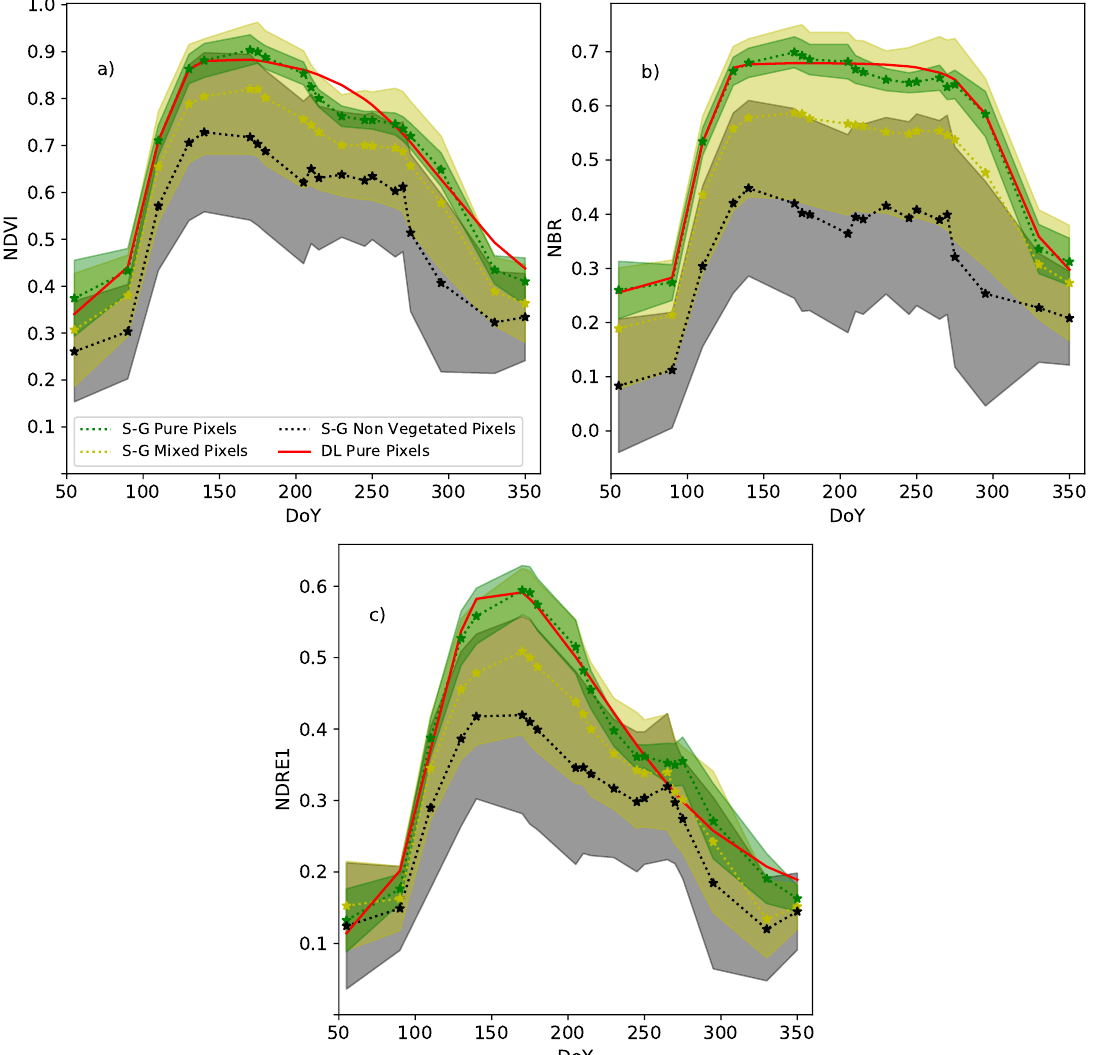
Figure 8. Savitzky–Golay reconstruction of the 2018 phenological curves as described by NDVI ( a ), NBR ( b ) and NDRE1 ( c ) for Canal de Brienne area and for vegetation pixels in green, mixed pixels in yellow and non-vegetated pixels in black. Dashed lines and stars represent the mean of VI time series and the area around represent the standard deviation. The red continuous curve represents the mean behavior of D-L fits on vegetation